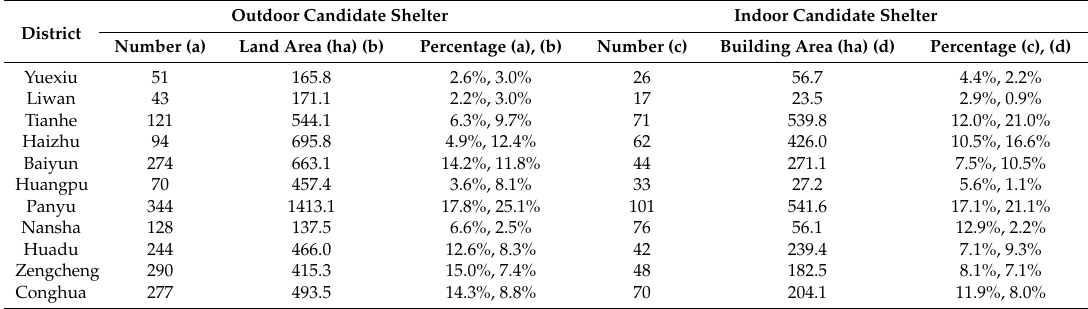
Table 4. Existing available resources as a candidate shelter.